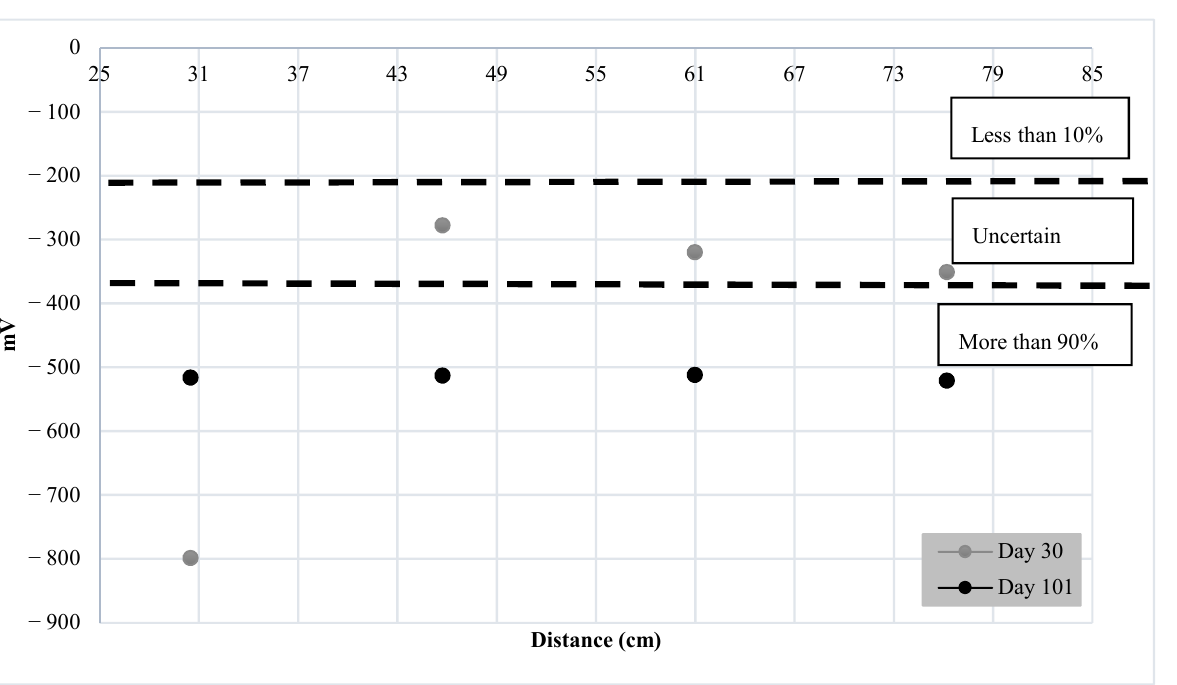
Figure 10. Specimen B- Day 132 condition verification: Very mild corrosion build-up on the rebar.